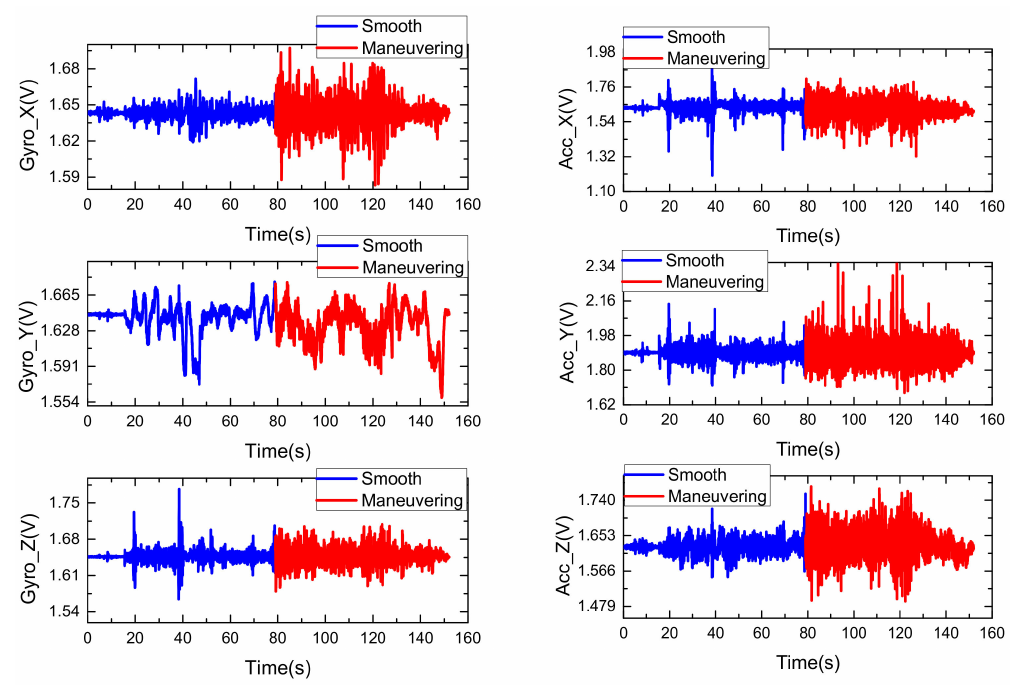
Figure 6. The original outputs of the tri-axis gyroscope ( left ) and accelerometer ( right